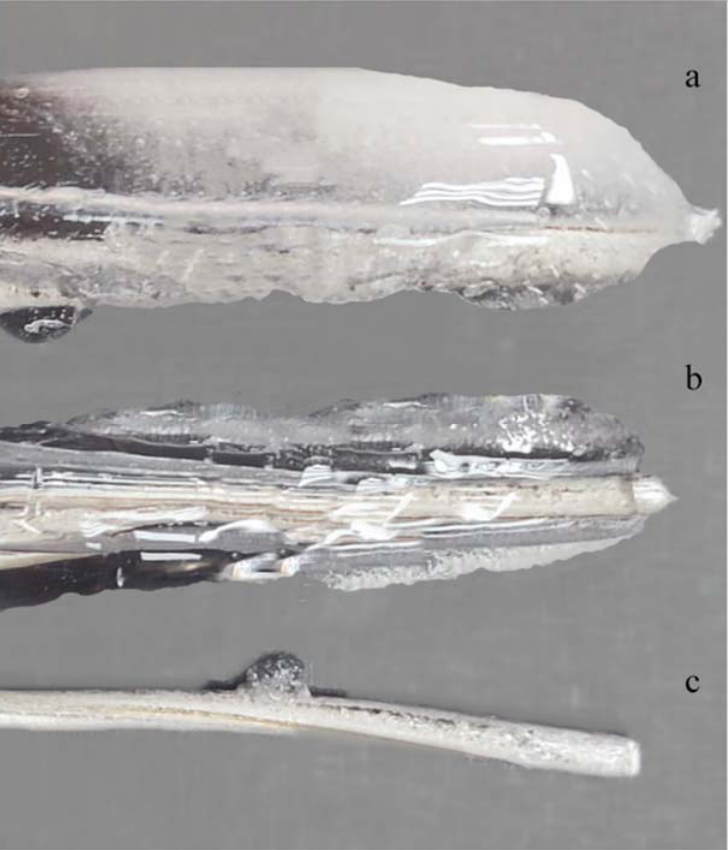
Figure 20. Photograph of ABE wire after climate chamber: ( a ) control sample ( b ) ABE wires treated by immersion in SiO 2 nanoparticles sol ( c ) ABE wires treated by sequential immersion in tetraethoxysilane and ammonia.